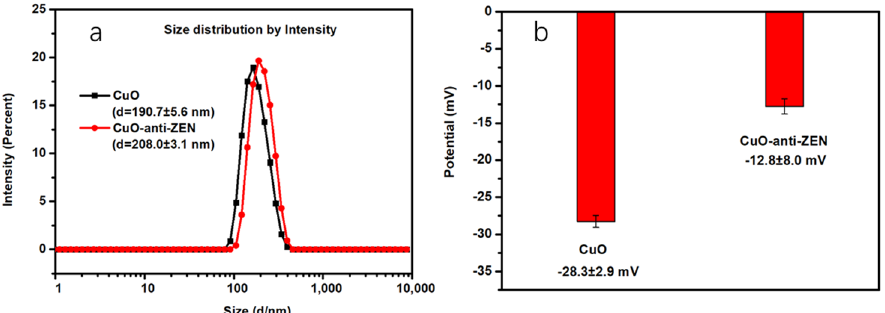
Figure 1 . Characterization of antibody-labeled CuO NPs by Zeta-sizer Nano-ZS90 instrument. ( a ) Size distribution and ( b ) zeta potentials of CuO NP colloid and CuO NP-anti-ZEN. ( a ) Size distribution and ( b ) zeta potentials of CuO NP colloid and CuO